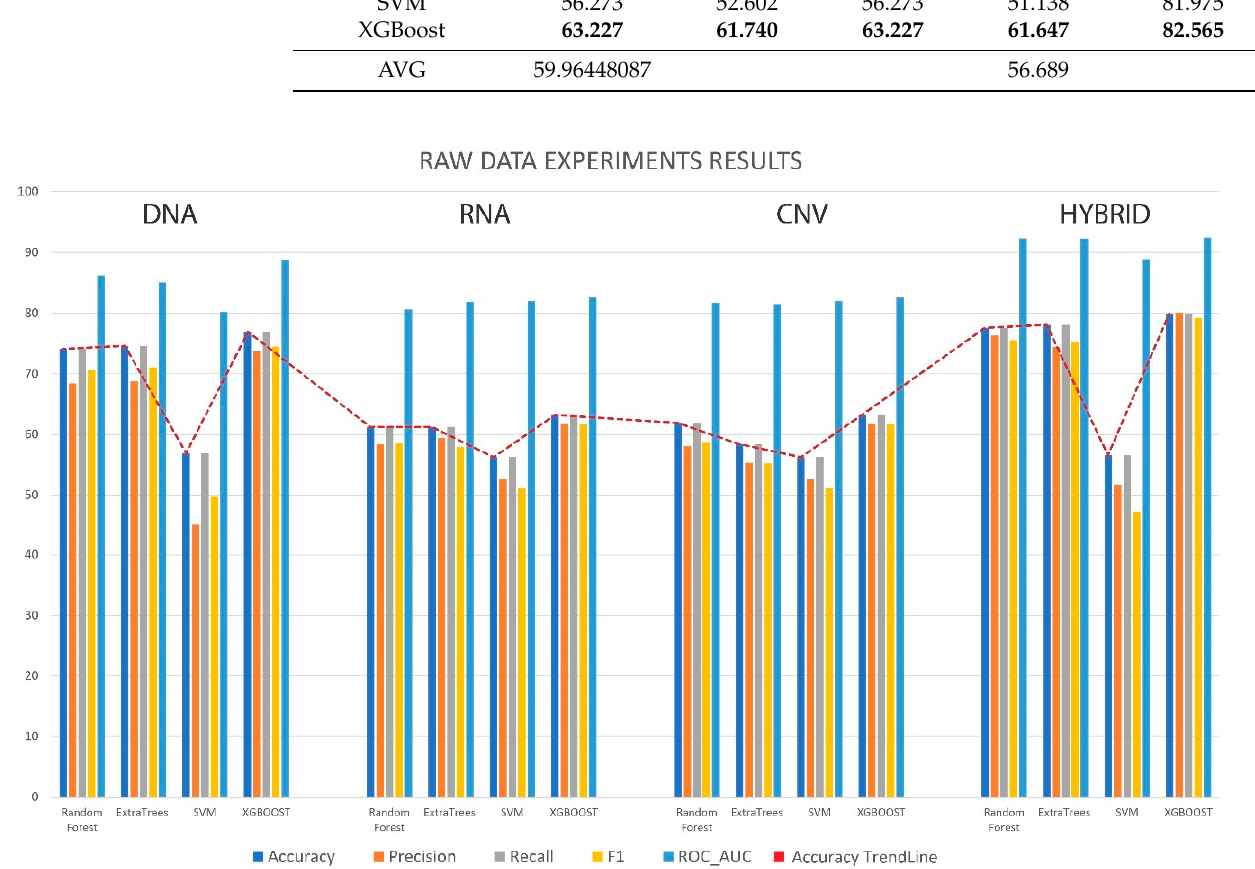
Figure 2. Baseline Results Summary.